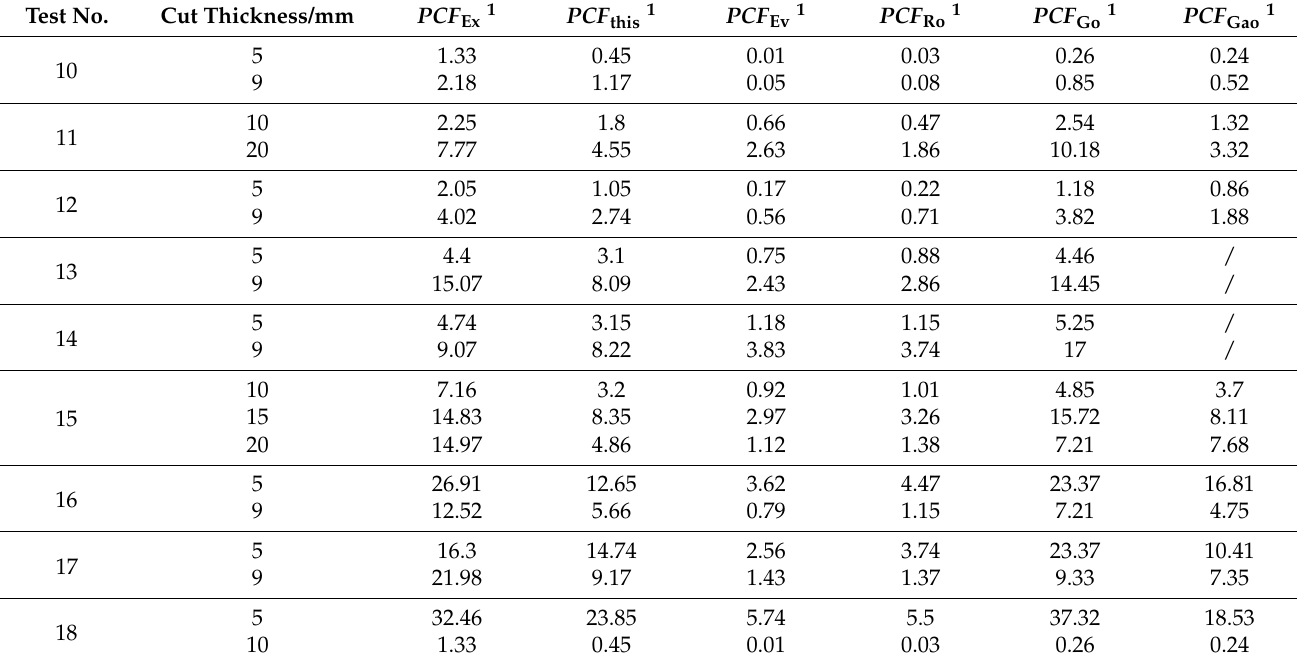
Table 5. The added value of PCF obtained by full-scale rock cutting experiments and theoretical models for the second prediction performance